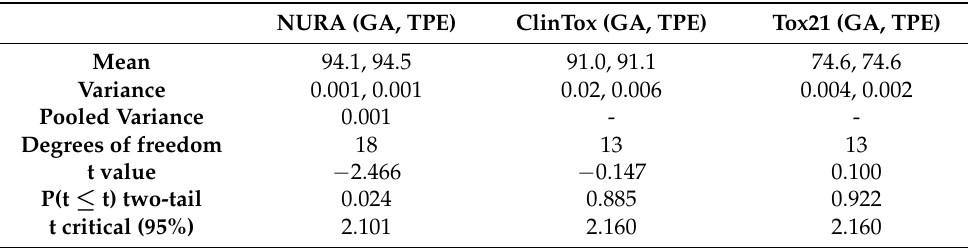
Table A2. Two-tailed t-test with a hypothesized zero mean difference for the three datasets consider- ing the best result among 10 replicas between genetic algorithms (GA) and tree-structured Parzen estimator (TPE) on 3-fold cross validation. Variances were assumed unequal for Tox21 and ClinTox ( p -value of F test 0.017 and 0.024, respectively).